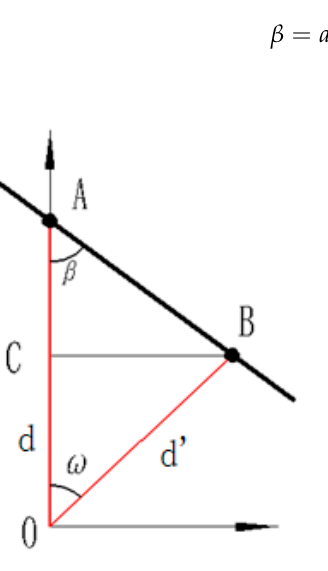
Figure 3. The non-ground point segmentation model based on the range image method [15]. According to the angle β , determine whether the target points scanned by the adjacent laser scan beams are on the same object, and set the threshold angle θ . If β > θ , they are on the same object, otherwise, they are on the different object.